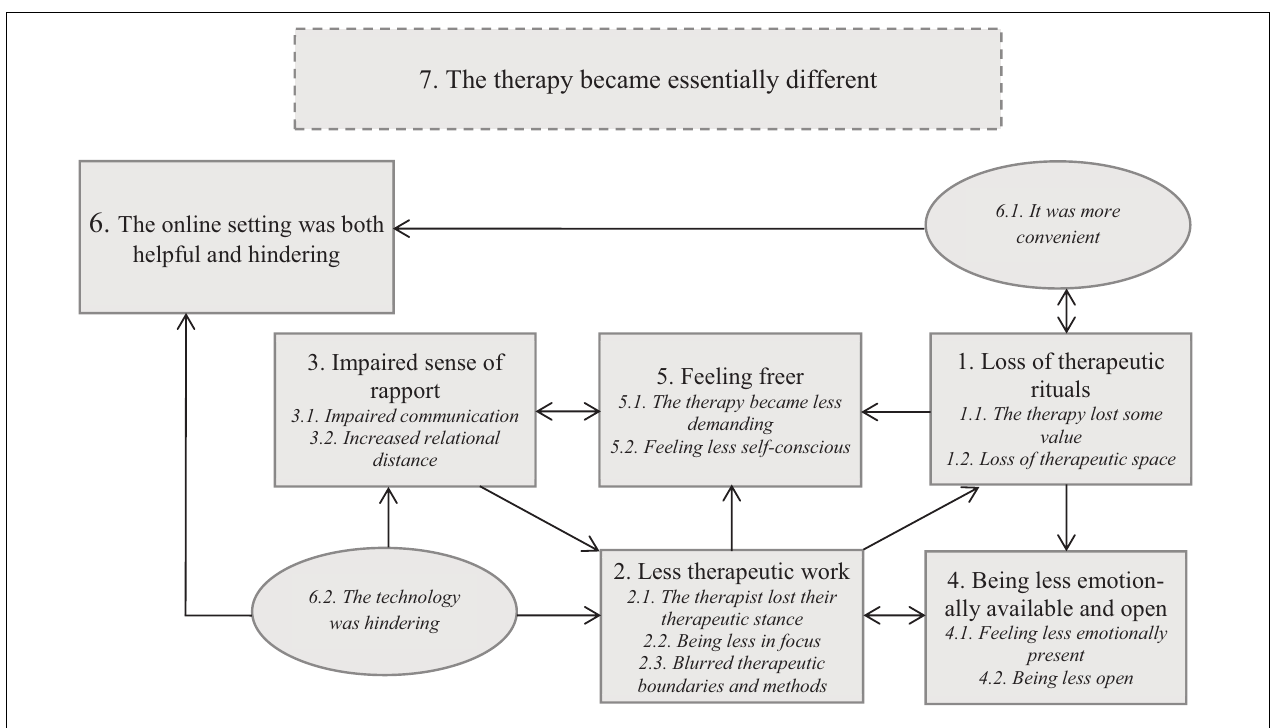
FIGURE 1 | A tentative model of interconnections between themes of